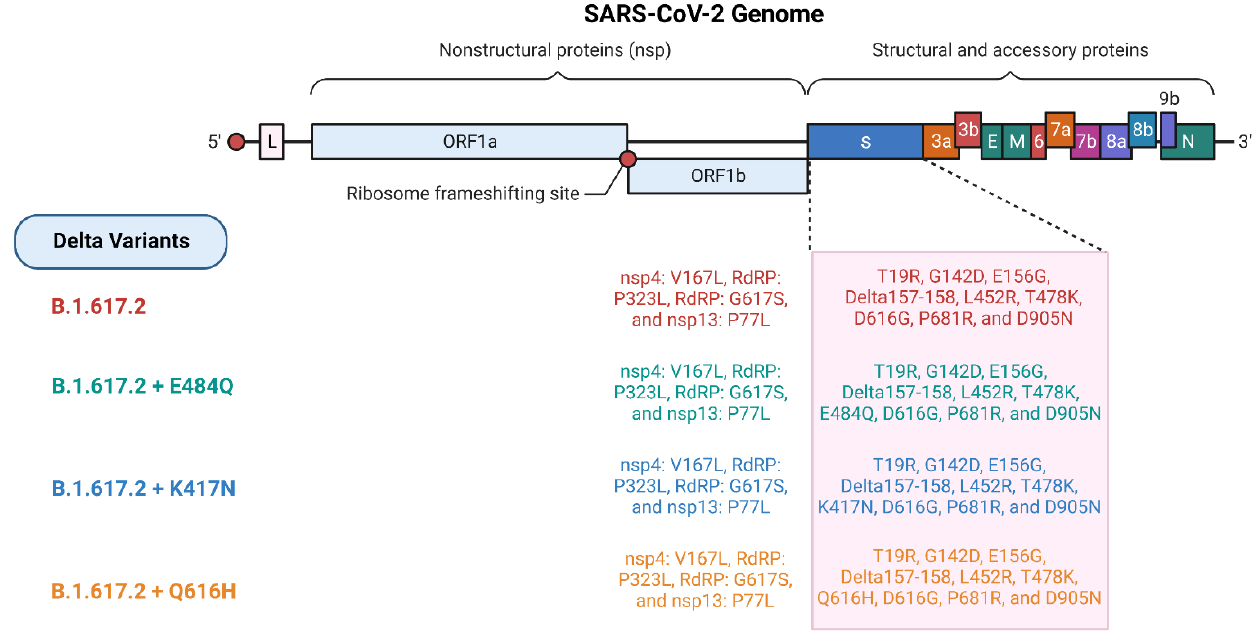
Figure 3. Different lineages of SARS-CoV-2 Delta variants (created with Biorender.com).